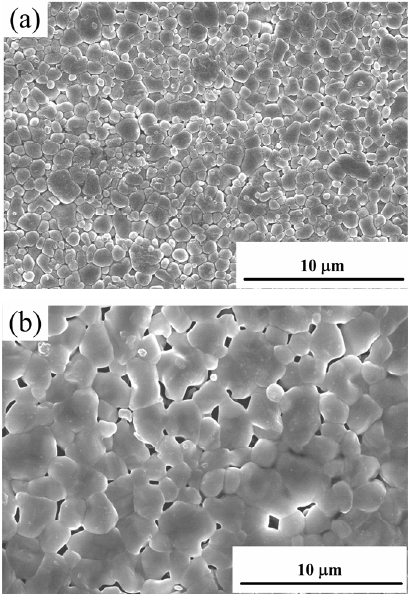
Fig. 2 Microstructure of the ZrSiO 4 bulk (a) before and (b) after corrosion.